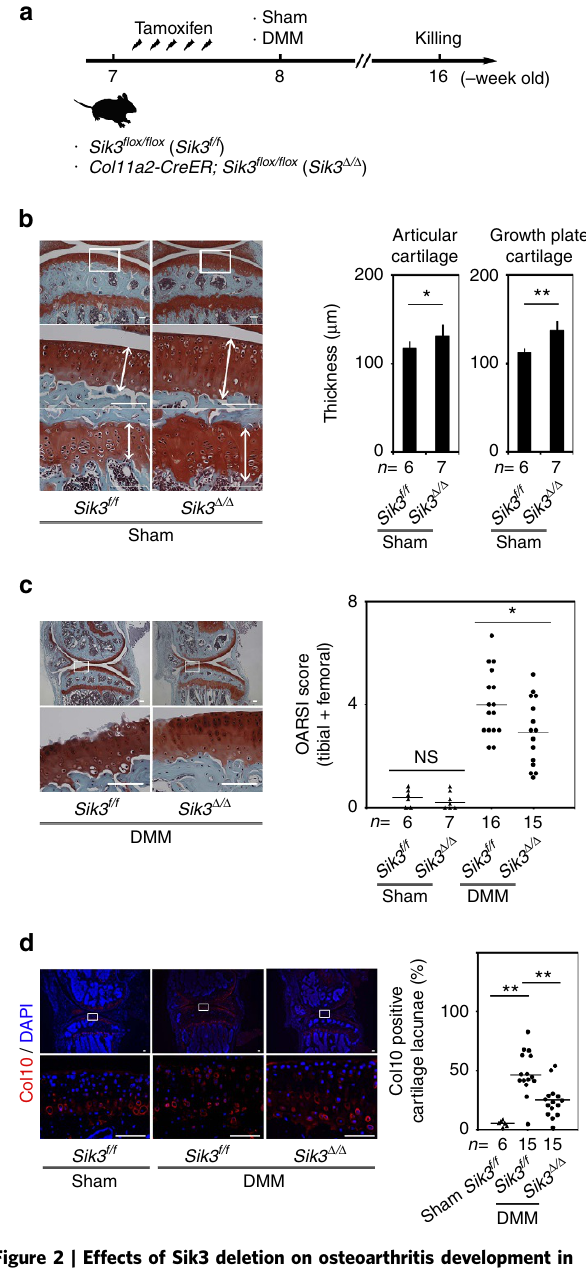
Figure 2 | Effects of Sik3 deletion on osteoarthritis development in DMM-operated knees. ( a ) Protocol of experiments: 7-week-old mice were intraperitoneally injected with tamoxifen for 5 consecutive days, had their right knees subjected to DMM or sham surgeries, and were killed at 16 weeks of age. ( b ) Histology of proximal tibia in sham-operated knees. Safranin O-fast green-iron haematoxylin staining. The thickness of articular cartilage and growth plate cartilage are shown in the graph. t -test. ( c ) Histology of articular cartilage of proximal tibia in DMM-operated knees. Boxed regions are shown in the bottom panels. OARSI scores of articular cartilage in sham- and DMM-operated knees are shown. Two blinded scorers gave consistent results. Mann–Whitney test. ( d ) Immunohistochemistry for Col10 in knees. Boxed regions in the top panels are shown in the bottom panels. The percentage of lacunae surrounded by Col10-positive matrix per total number of lacunae are shown in the right graph. Tukey–Kramer post hoc test. Error bars denote means ± s.d. Numbers of mice examined are indicated at the bottom of the graphs. * P o 0.05 and ** P o 0.01. NS, not significantly different. Scale bars, 100 m